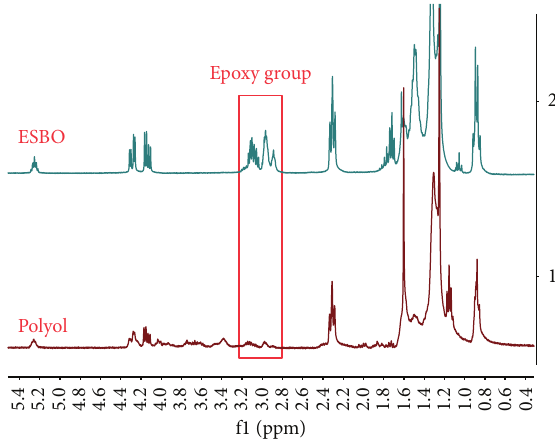
Figure 10: 1 H-NMR spectrum of polyols with various reaction